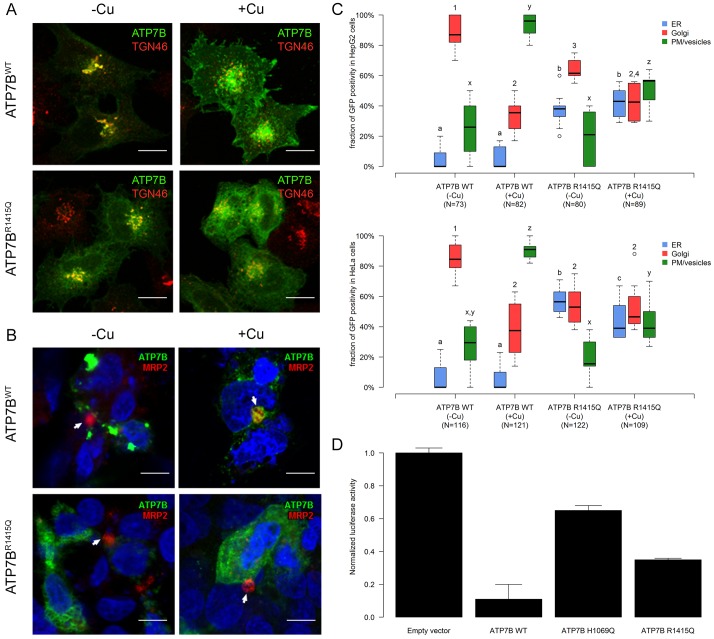
Functional evaluation of ATP7BR1415Q. (A) HeLa cells were transfected with either ATP7BWT or ATP7BR1415Q and either treated with 500 µM of the copper chelator BCS (Cu−) or incubated for 2 h with 200 µM CuSO4 (Cu+). In low-copper conditions, the localization of ATP7BWT overlapped with the trans-Golgi marker TGN46, whereas copper stimulation induced ATP7BWT trafficking to cytosolic vesicular structures and the cell surface (upper row). A significant cohort of ATP7BR1415Q was detected in the endoplasmic reticulum network-like membranes in both low- and high-copper conditions (lower row). White scale bars: 5 µm. (B) Polarized HepG2 cells were exposed to BCS or CuSO4 for 4 h and stained with canalicular marker MRP2 and nuclear marker DAPI. White arrows indicate canalicular vacuole (cyst), which does not contain either wild-type or mutant ATP7B in chelator-treated cells. In contrast, the canalicular vacuole receives ATP7BWT upon Cu stimulation, whereas ATP7BR1415Q fails to reach the canalicular surface domain. White scale bars: 5 µm. (C) The intracellular distribution of GFP-tagged ATP7BWT and ATP7BR1415Q protein was analysed in HeLa (lower graph) and HepG2 (upper graph) cells in low- and high-copper circumstances. The number of cells used for quantification is indicated in parentheses. Significant differences (P<0.05) in the distribution of GFP within the cellular compartments are indicated with a,b,c (ER), 1,2,3 (Golgi) or x,y,z (plasma membrane or vesicles). There was an increase in the percentage of cells that exhibited GFP signal in the endoplasmic reticulum upon expression of ATP7BR1415Q-GFP, whereas the number of cells with ATP7BWT-GFP in the endoplasmic reticulum was very low in both HeLa and HepG2 cells. (D) HeLa cells were transfected with empty vector, ATP7BWT, ATP7BH1069Q or ATP7B R1415Q and the metal-responsive element (MRE)-luciferase reporter for 24 h and treated with 200 μM CuSO4 for 24 h. Induction of the MRE-luciferase reporter was reduced when ATP7BWT was co-expressed in the cells, whereas transfection of the partly active ATP7BH1069Q mutant resulted in only modest inhibition of MRE-luciferase activation. Cells expressing ATP7BR1415Q exhibited substantial reduction of reporter activity, indicating that ATP7BR1415Q is still capable of transporting copper away from the cytosol. Bars represent the mean values of normalized luciferase activity (see Materials and Methods), and standard deviation is depicted by the error bars.